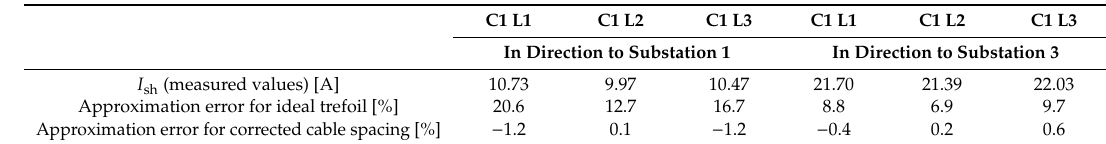
Table 1. Influence of the cable spacing on sheath currents measured in Substation 2; C1 L1—cable 1, C1 L2—cable 2, C1 L3—cable